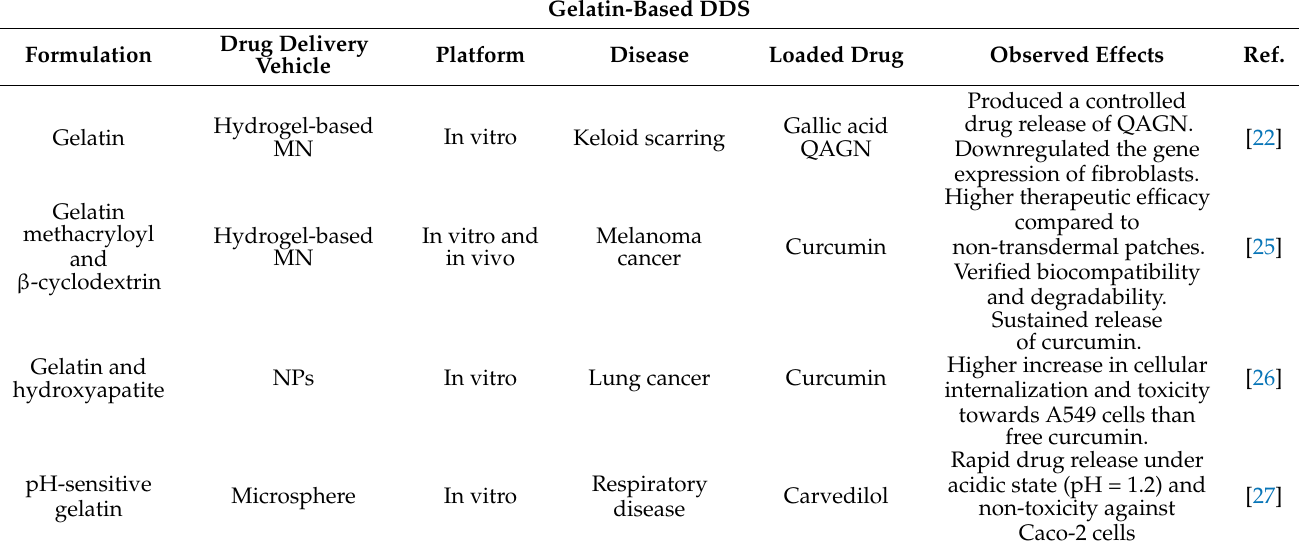
Table 1. Summary of studies on gelatin-based